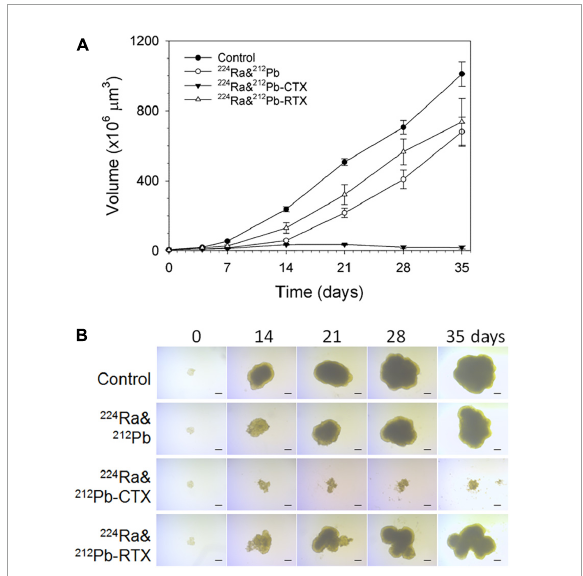
FIGURE4 The influence of dual targeting alpha solution on prostate cancer multicellular LNCaP spheroid growth after incubation for 4 h. (A) Growth of spheroids treated with 1 kBq/ml 224 Ra& 212 Pb, 224 Ra& 212 Pb-TCMC-cetuximab (CTX), and 224 Ra& 212 Pb-TCMC- rituximab (RTX, negative control) groups was measured for up to 35 days and is presented as volume ( × 10 6 µ m 3 ) ± SD . The images of LNCaP spheroids were measured for up to 35 days. (B) Representative microscope images ( × 4 magnification) were taken at the predefined study end point of 35 days using a bright-field microscope with AxioVision Rel. 4.8 software. LNCaP spheroids were generated by cultivation of cells in liquid overlay in 1.5% agarose-coated flat bottom 96-well plates (94). Cell suspensions of 500 cells in 100 µ L medium were added to each well, followed by centrifugation of the plates at 470 × g for 15 min. After an initial incubation time of 3 days, spheroids with diameter of ∼ 229 µ m were formed.